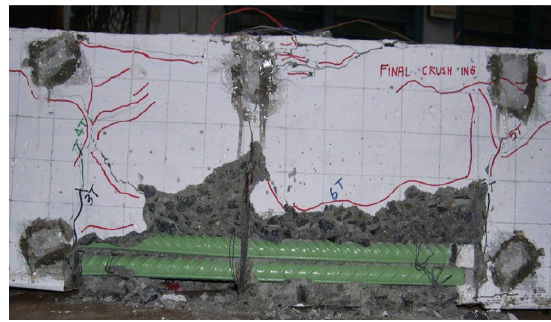
Figure 9. Splitting failure of beam with epoxy